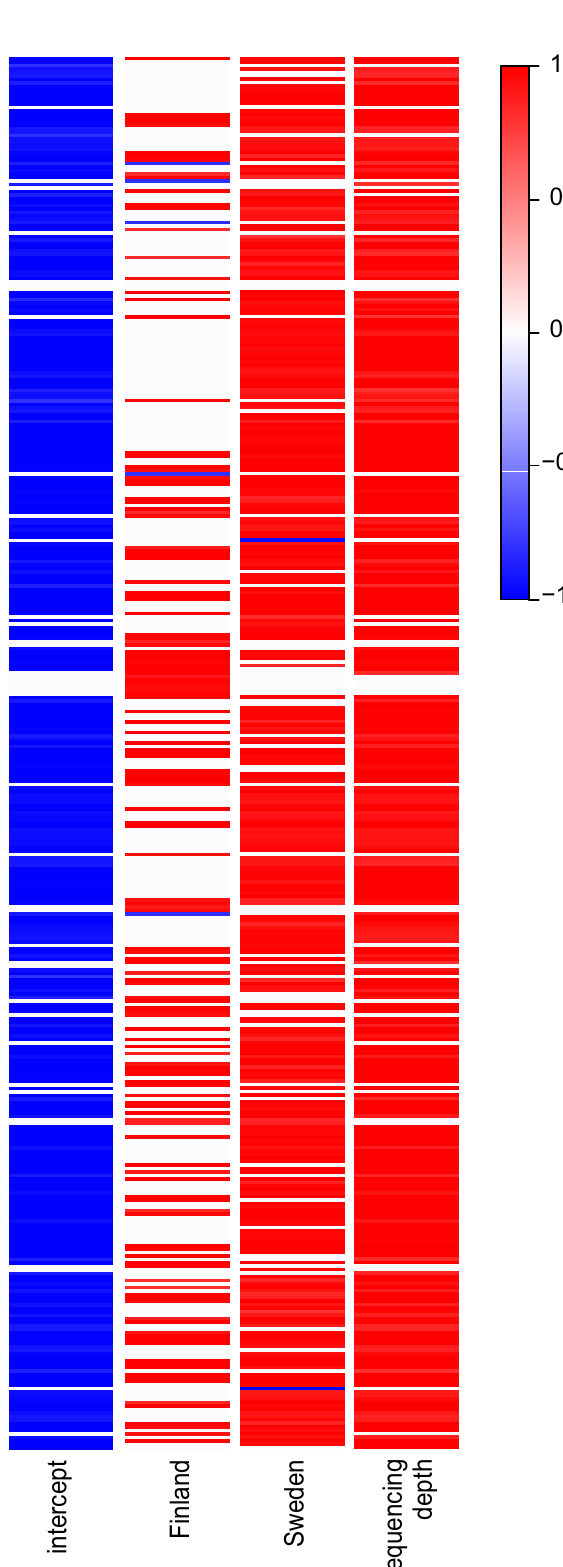
Figure 5. The effect of the covariates of the joint species distribution model, fitted to the plant genera by metagenomics, to each genus, shown by the beta values. Positive beta values showing the genera that respond positively to a covariate, are given in red, and negative values, showing the genera responding negatively, with blue. The strength of the posterior support to the beta values is indicated by the darkness of the colour, shown in the bar. The intercept is country Estonia, and the covariates are the two other countries and the sequencing depth (read count). The plant genera in the plot are listed in Supplementary Table S6, showing the beta values with high (> 95%) posterior